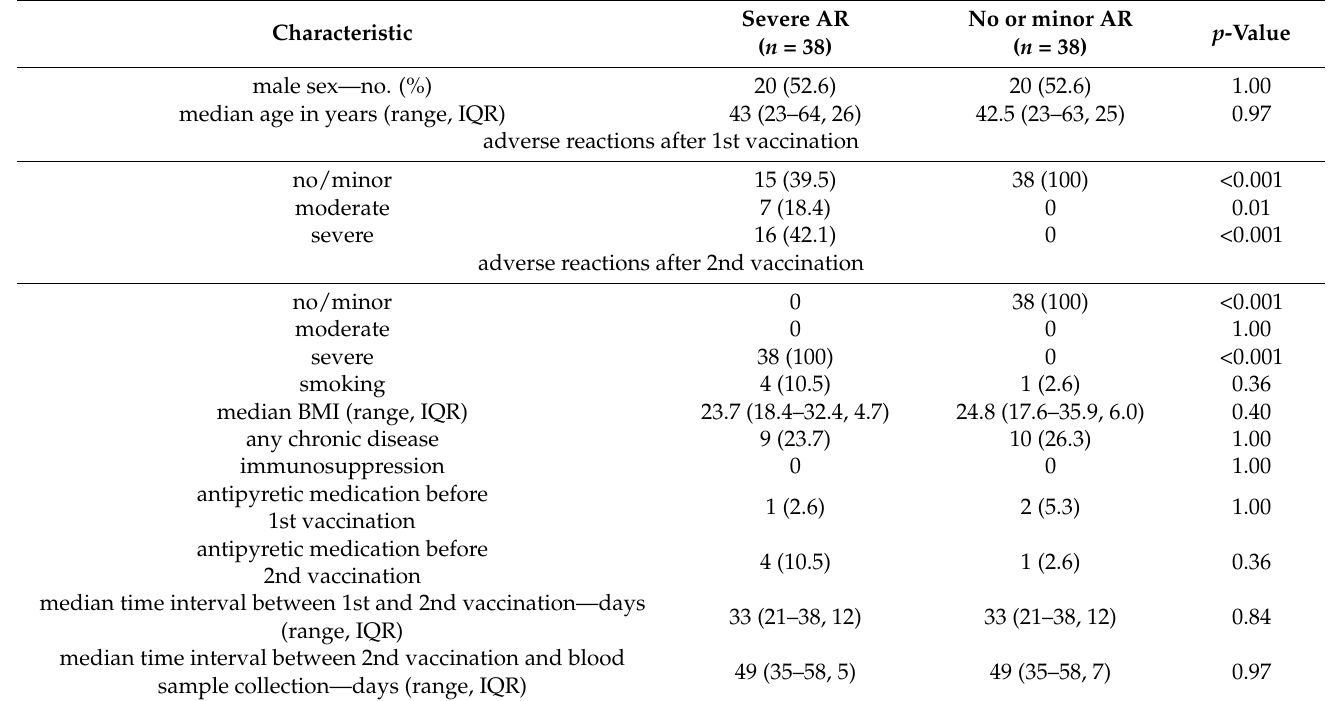
Table 3. Characteristics of vaccinees according to reactogenicity group. AR = adverse reaction(s); IQR = interquartile range; BMI = body mass